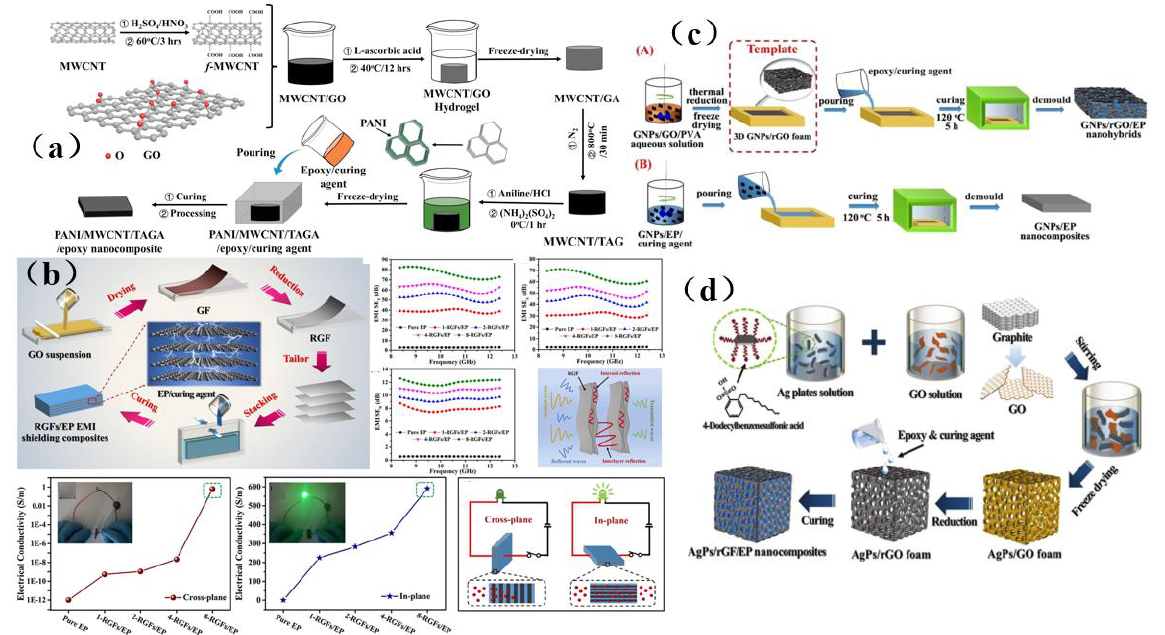
Figure 17. ( a ) Preparation schematic diagram and performance test of PANI/MWCNT/thermally annealed graphene aerogel/epoxy electromagnetic interference shielding nanocomposites [138]. Copyright 2019, Elsevier. ( b ) Schematic depiction of the fabrication process leading to RGF S /EP EMI shielding composite material [62]. Copyright 2019, Elsevier. ( c ) aA: Schematic diagram of the preparation pathway leading to three-dimensional GNPs/rGO/EP nanocomposites by the template method, bB: Schematic diagram showing the preparation of GNPs/EP nanocomposites by a traditional blend- ing casting method [139]. Copyright 2019, Royal Society of Chemistry. ( d ) Schematic diagram showing the preparation of three-dimensional AgPs/rGF/EP nanocomposites [140]. Copyright 2019, Royal Society of